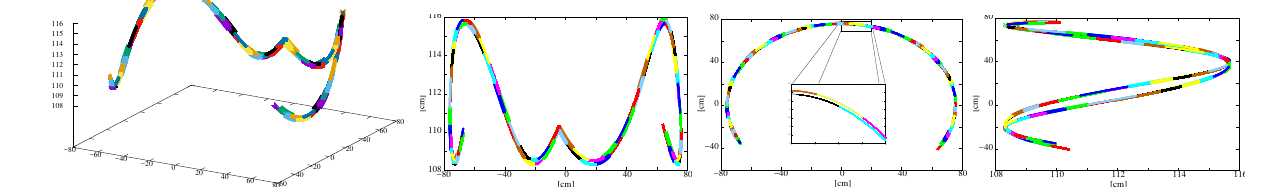
Figure 5. Trajectory describing a circular arc in the horizontal plane. Cf. Figure 7. From left to right: 3D view and detailed view. Vertical, horizontal, and vertical orthographic projection.